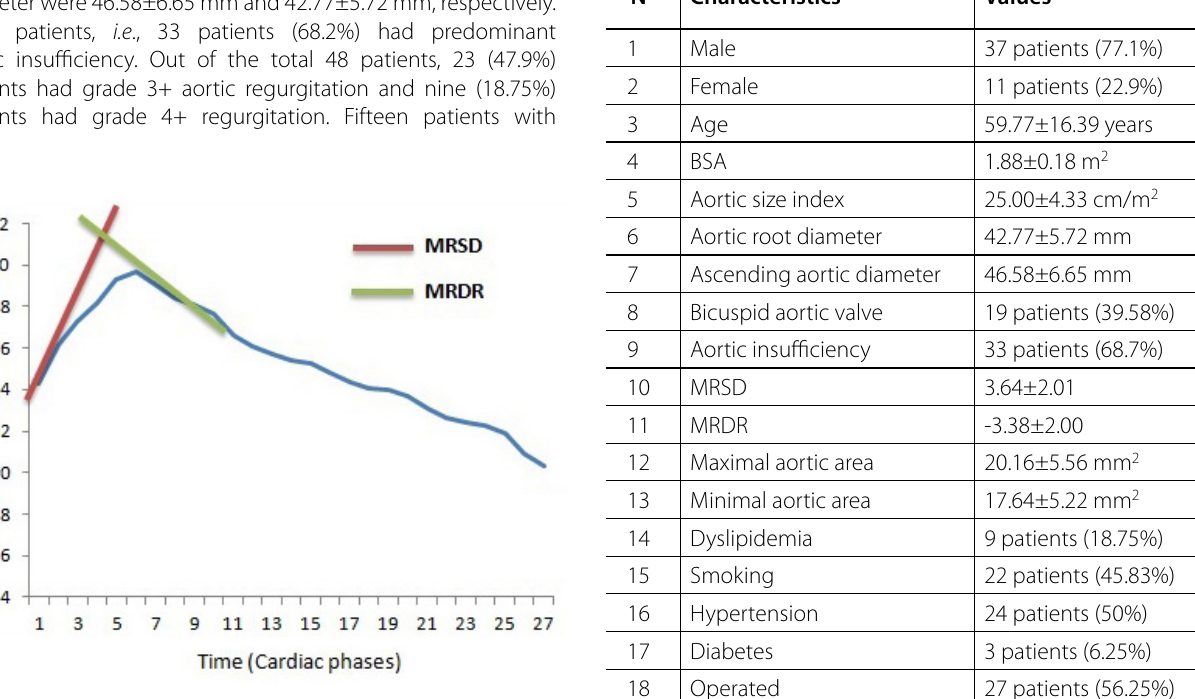
Fig. 2 – Area/time curve of the ascending aorta. MRDR=maximal rate of diastolic recoil; MRSD=maximal rate of systolic